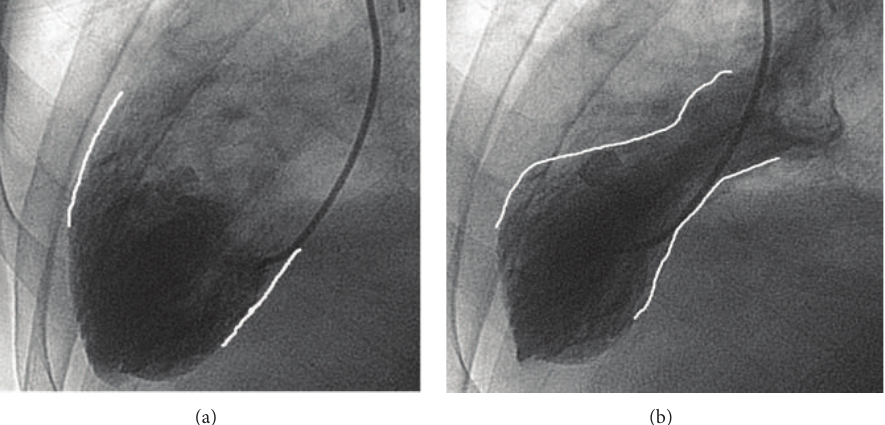
Figure 3: Ventriculograms showing the heart at end diastolic volume (a) and at end systolic volume (b), revealing apical ballooning seen in Takotsubo’s. Outlining used for enhanced visualization of the ventricle wall for comparison. Table 1: Showing percentage of Takotsubo’s patients with LV thrombi and the number of embolic events resulting from each thrombus. Study Number of LV thrombi in patients with Takotsubo’s de Gregorio et al. (2008) [25] 15/600 (2.5%) a 3/5 (60%) Mitsuma et al. (2010) [27] 3/21 (14%) 2/3 (66%) Haghi et al. (2008) [26] 4/52 (8%) 0/4 (0%) b a Percentage reported in article. Total Takotsubo’s cases (600) were derived from that percentage. b Documented use of anticoagulants prevented embolic